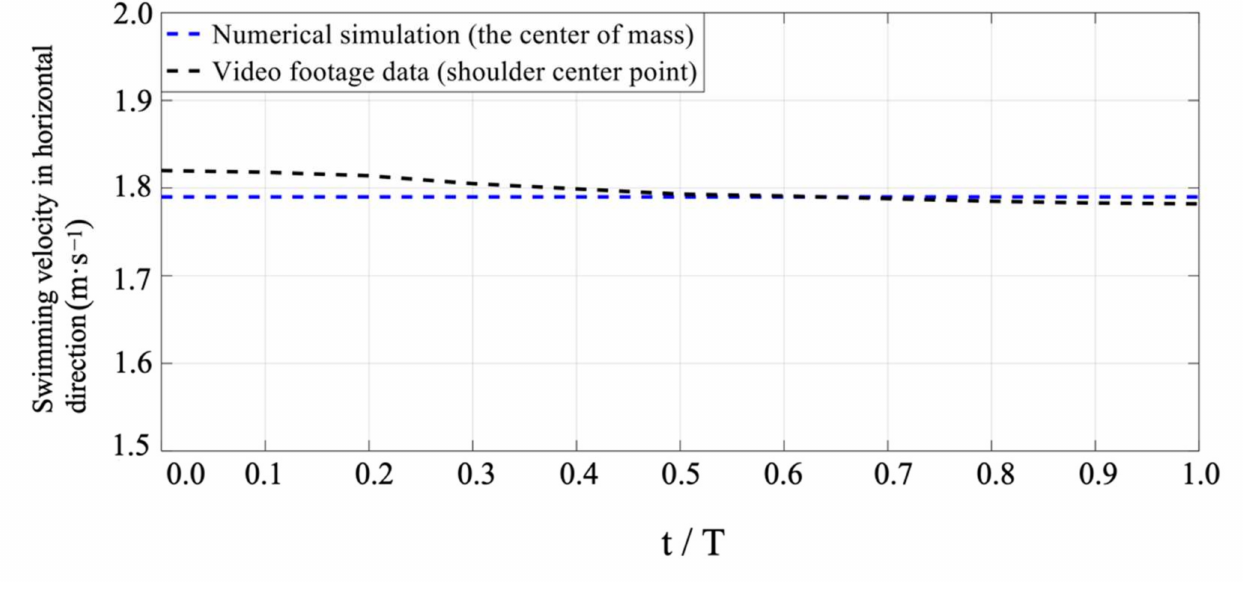
Figure 6. Comparison of video and numerical results in horizontal